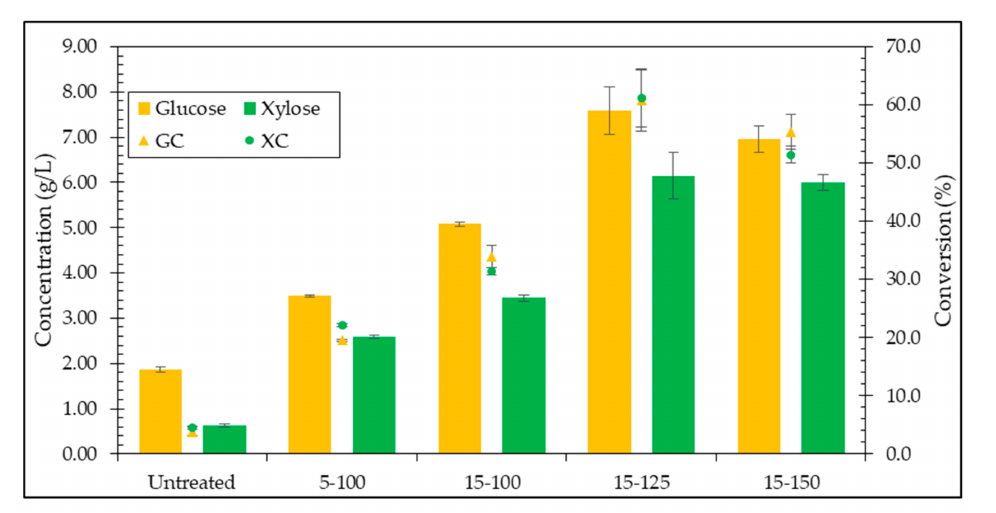
Figure 2. Glucan and xylan conversions (GC, XC) in % of theoretical (spare marks, right) and glucose and xylose concentration in the media in g / L (plain bars, left), after enzymatic hydrolysis of raw OS and OS